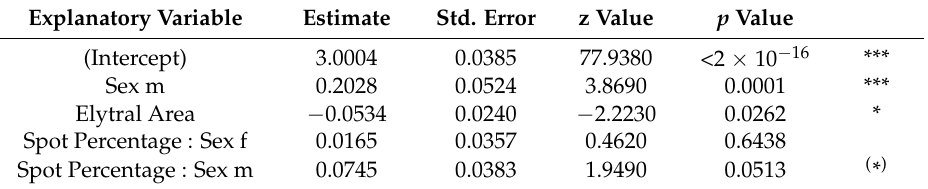
Table 2. Results for the model addressing the intensity of infection of Ha. axyridis with H. virescens . Explanatory Variable